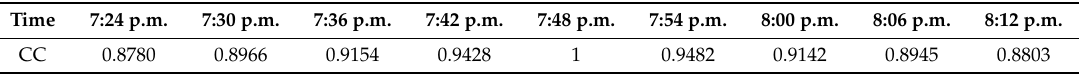
Table 2. Elevation cuts correlation at the same elevation angles in neighbor